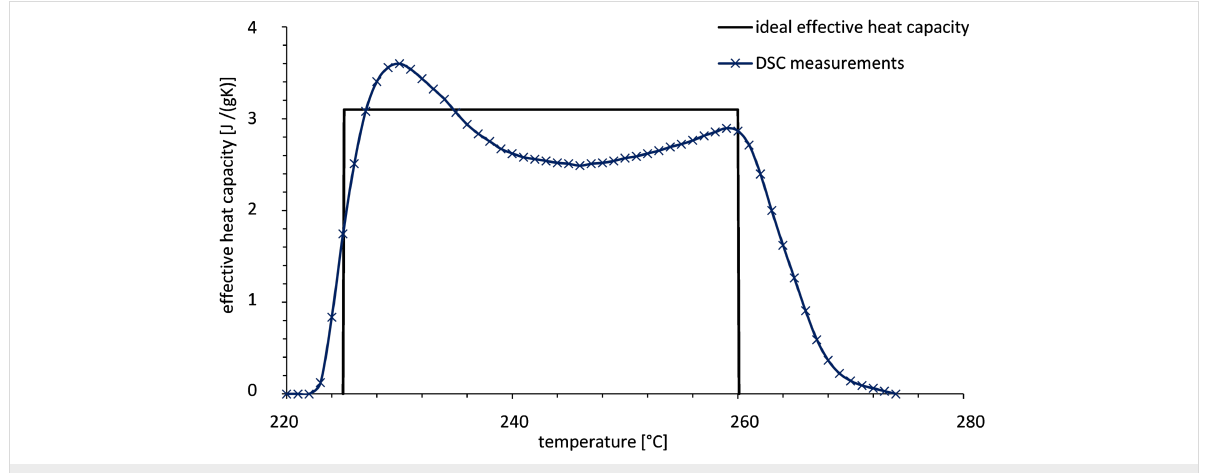
Figure 13: Specific enthalpy of fusion for the salt mixture KNO 3 –NaNO 3